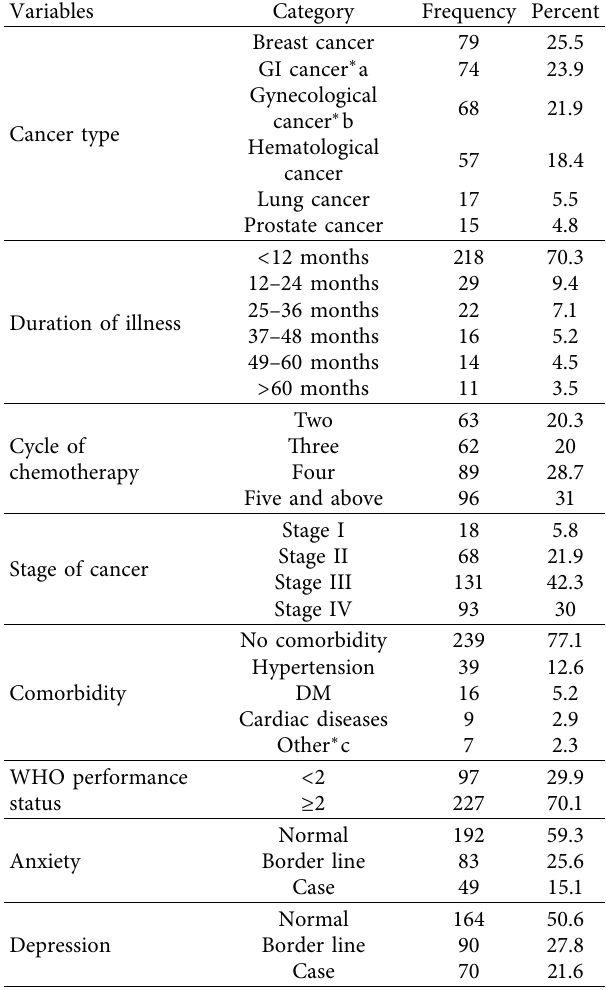
Table 2: Clinical characteristics of adult cancer patients under- taking chemotherapy treatment at HUCSH, Hawassa, Southern Ethiopia,